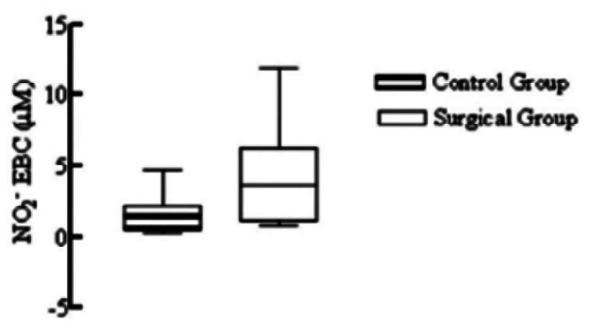
Fig. 1 - Comparison of EBC NO 2- levels in the pre-operative period and control group